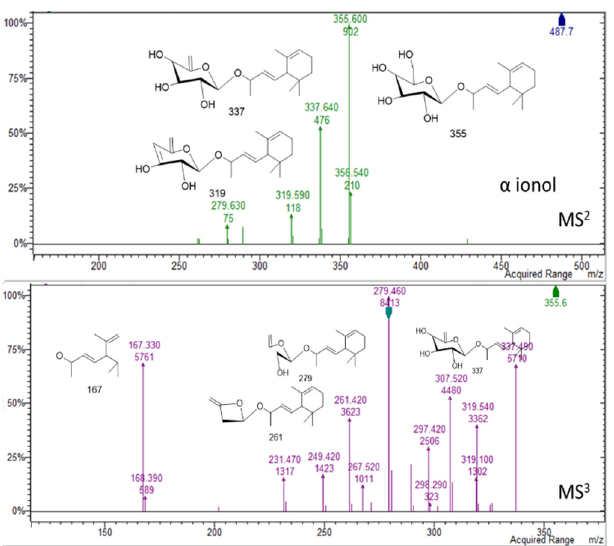
Figure 7 . Mass spectral details of dihydro α ionol- O -[arabinosil(1-6) glucoside]. Figure 7. Mass spectral details of dihydro α ionol- O -[arabinosil(1-6)